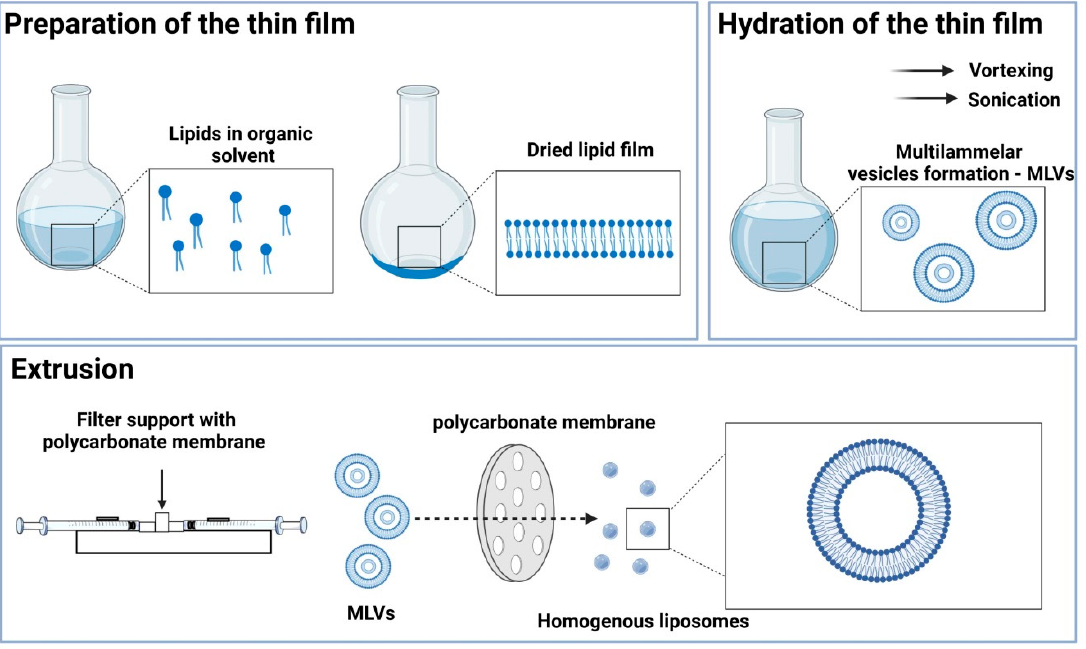
Figure 2. The schematic illustration of liposomes preparation protocol using the thin-film hydration followed by extrusion method. The image was prepared according to Zhang [26] and created with BioRender.com and Servier Medical Art (last accessed on 10 January 2022).